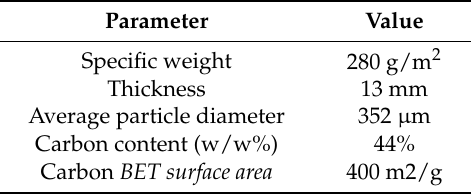
Table 4. Activated carbon fiber clothes characteristics.